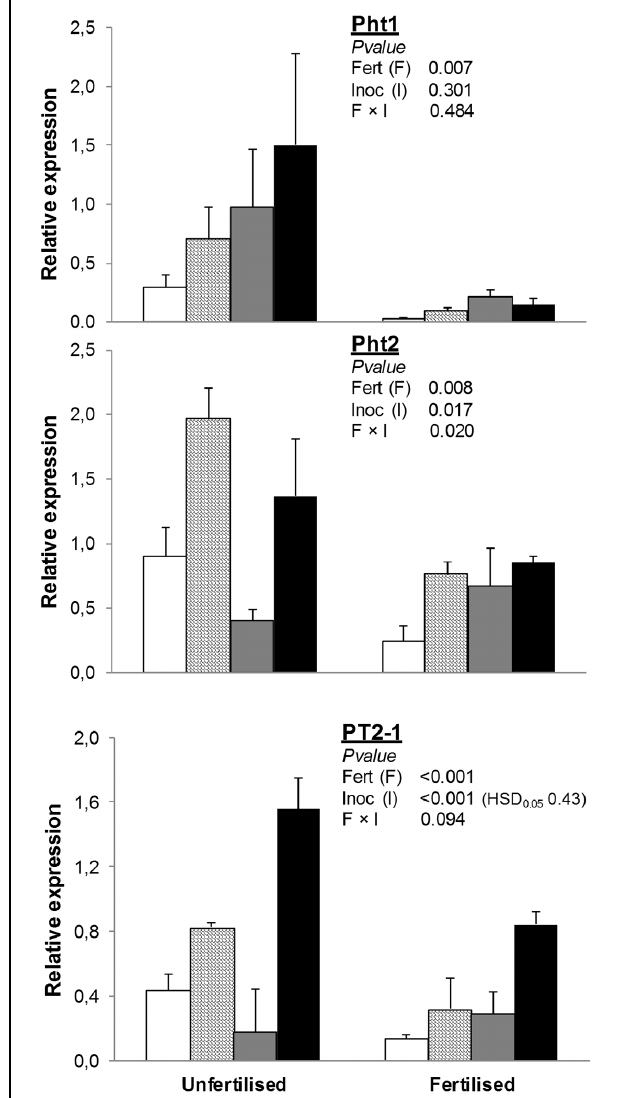
FIGURE 1 | Expression of phosphate transporter genes ( Pht1 , Pht2, and PT2-1 ) in Triticum durum root. Plants were grown under the unfertilized conditions or fertilized with an organic fertilized with low C:N ratio. Soil was left with the native microbial inoculum (NAT, white bars); inoculated with only arbuscular mycorrhizal fungi spores (AMF, scaled bars); only plant growth-promoting rhizobacteria (PGPR, gray bars), or both AMF + PGPR (black bars). Means ( n = 6) with standard errors, and analysis of variance results are shown. Fert is for fertilization treatment, Inoc for Inocula. Tukey’s honest significant difference (HSD 0 . 05 ) of Inocula is shown when Inocula, but not Fertilizer × Inocula interaction, is